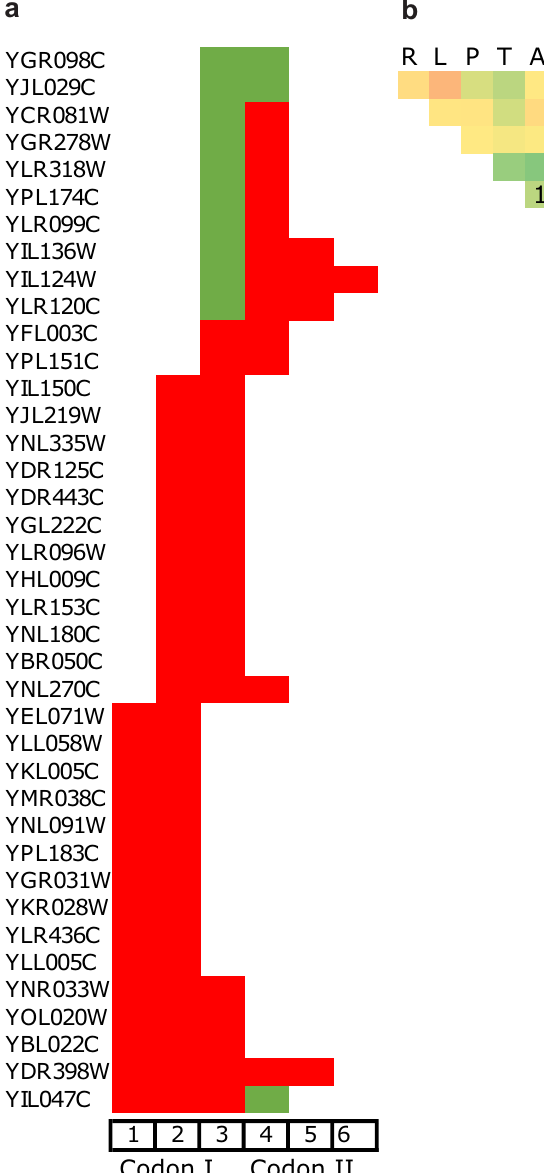
Figure 6. Effect of template switching on codons and amino acids. ( a ) Location of substitutions on two neighboring codons (six nucleotide positions). Synonymous substitutions are shown in green, and nonsynonymous substitutions are shown in red. For example, the MNM of gene YGR098C (top) are located in the 3rd position of the first codon and on the 1st position of the second codon. Both substitutions caused the synonymous changes shown in green. Similarly, YIL047C (bottom) has four neighboring substitutions spanning two codons. The first codon has three substitutions that replace the amino acid, shown in red, and the second codon has one synonymous substitution, shown in green. ( b ) The amino acid changes induced by MNMs in 39 proteins are shown; one event from its type per gene locus. The matrix is colored by Grantham’s physicochemical distance table 62 which has values of 5–215, with a mean distance of 100. Green represents similar amino acid pairs, while red represents distant amino acid pairs. Thirteen events had an amino acid with a physicochemical distance of 120 or higher (in